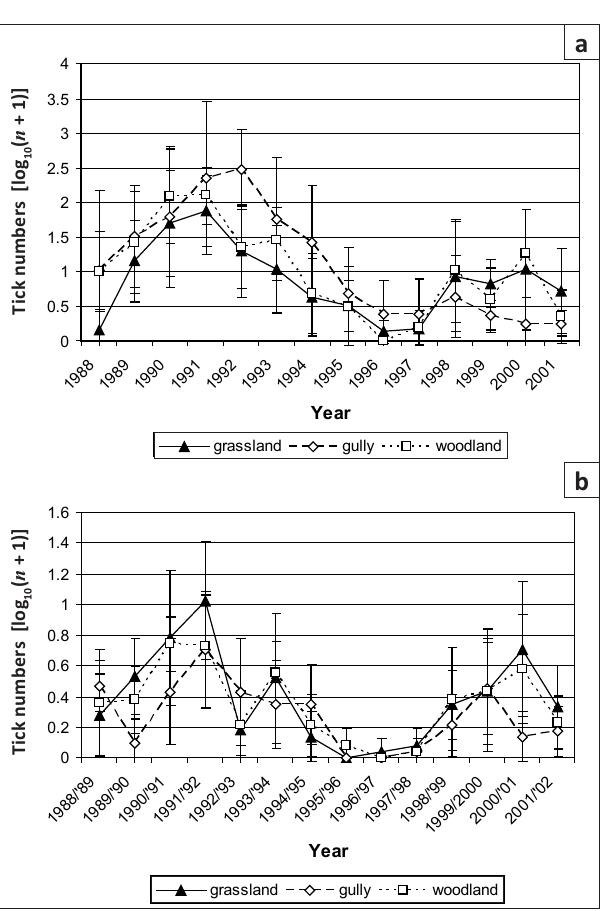
FIGURE 5: Mean (± 95% confidence interval) monthly collections of Rhipicephalus zambeziensis a) larvae and b) nymphs during the active periods of each year at Nhlowa Road and